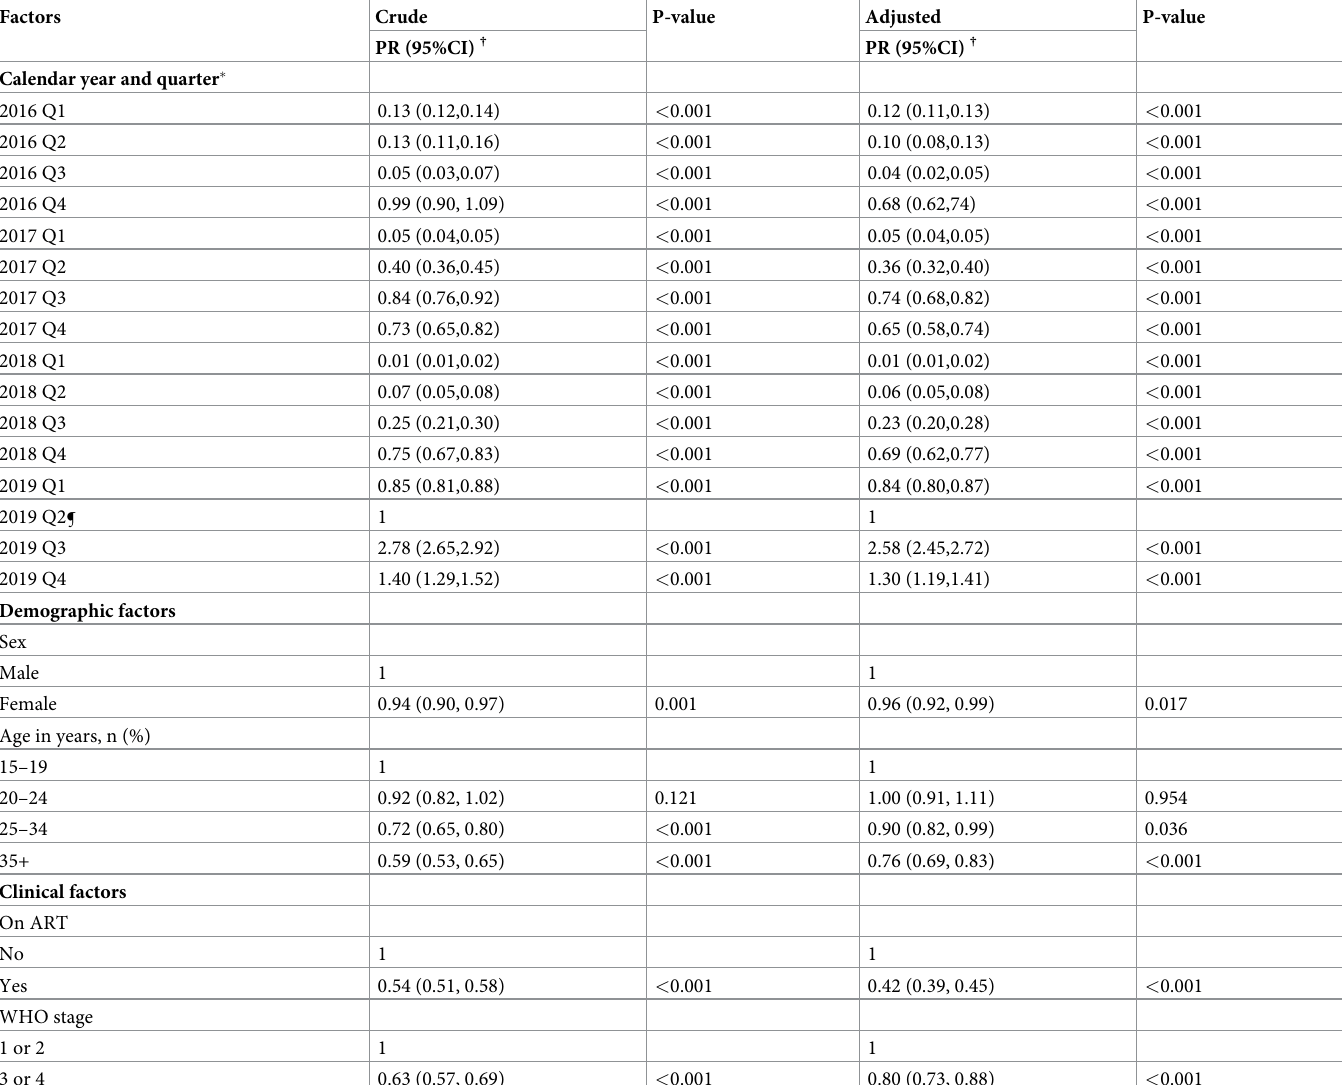
Table 2. Factors associated with TPT